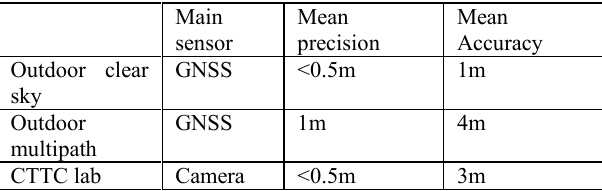
Table 3 . IOPES system horizontal performance at “CTTC-lab” test